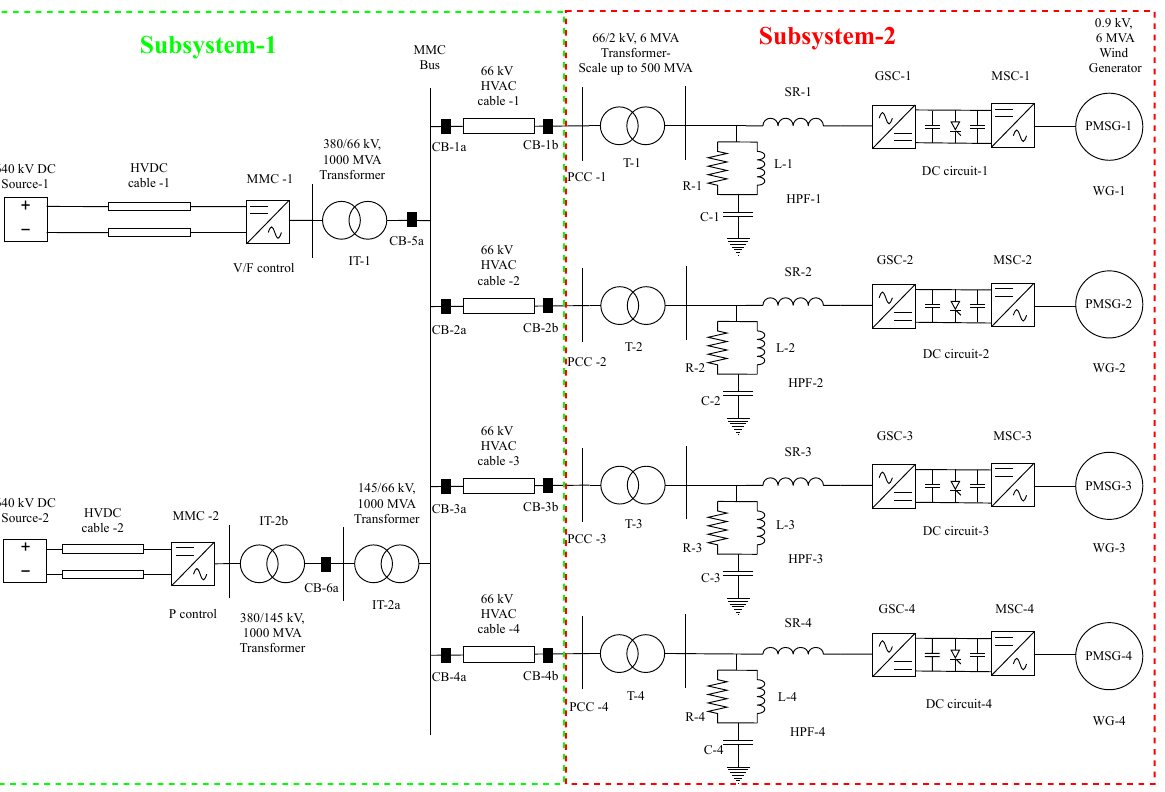
Figure 5. Single line diagram of 2 GW, 66 kV HVAC offshore network connected to 2 × 1 GW HVDC links with offshore converter stations in